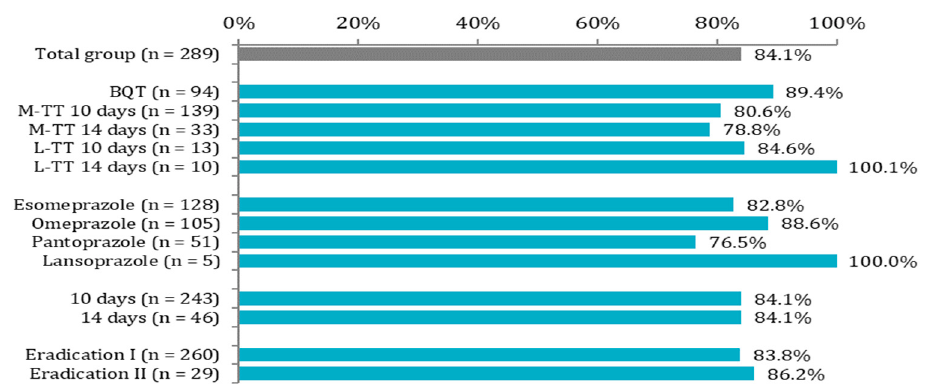
Figure 2. Comparison of the effectiveness rate in the total group and between treatment regimens, type of PPI, treatment duration, and eradication attempts. BQT—bismuth-based quadruple therapy, M-TT—metronidazole-based triple therapy, L-TT—levofloxacin-based triple therapy, PPI—proton pump inhibitor.